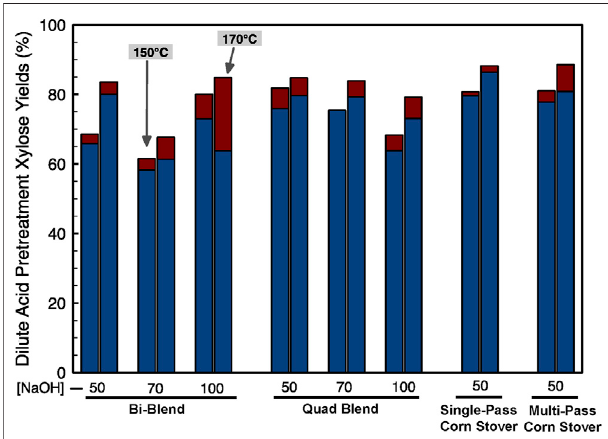
FIGURE 4 | Lignin and total xylose yields (left axis) of feedstocks after deacetylation and total xylose concentrations (right axis) in the black liquor. The left, middle, and right bars in each cluster represent low (50 kg NaOH/ ODMT and 80 ° C), medium (70 kg NaOH/ODMT and 92 ° C), and high severity (100 kg NaOH/ODMT and 92 ° C) deacetylation conditions, respectively. The deacetylation yields for lignin and total xylose are independent (not stacked).